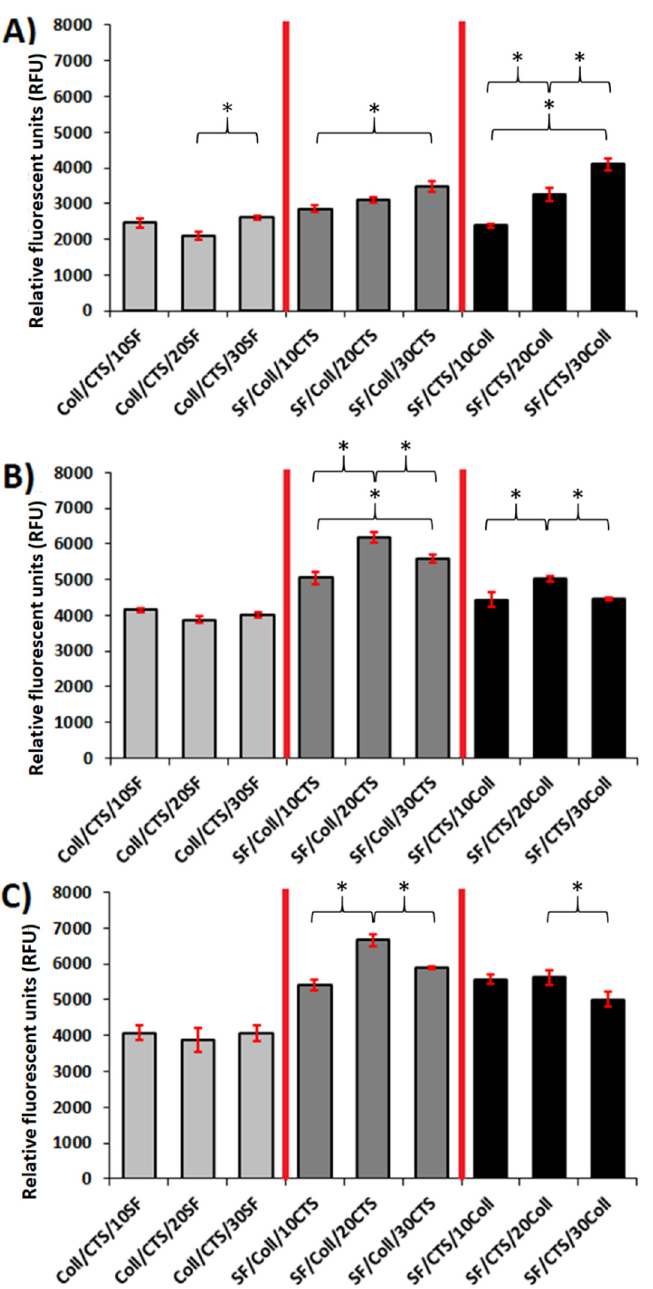
Figure 10. Metabolic activity after ( A ) 1 day, ( B ) 3 days, and ( C ) 7 days of MG-63 cells cultured on the studied scaffolds ( n = 3, mean ± SD, * significantly different between the groups, p < 0.05).